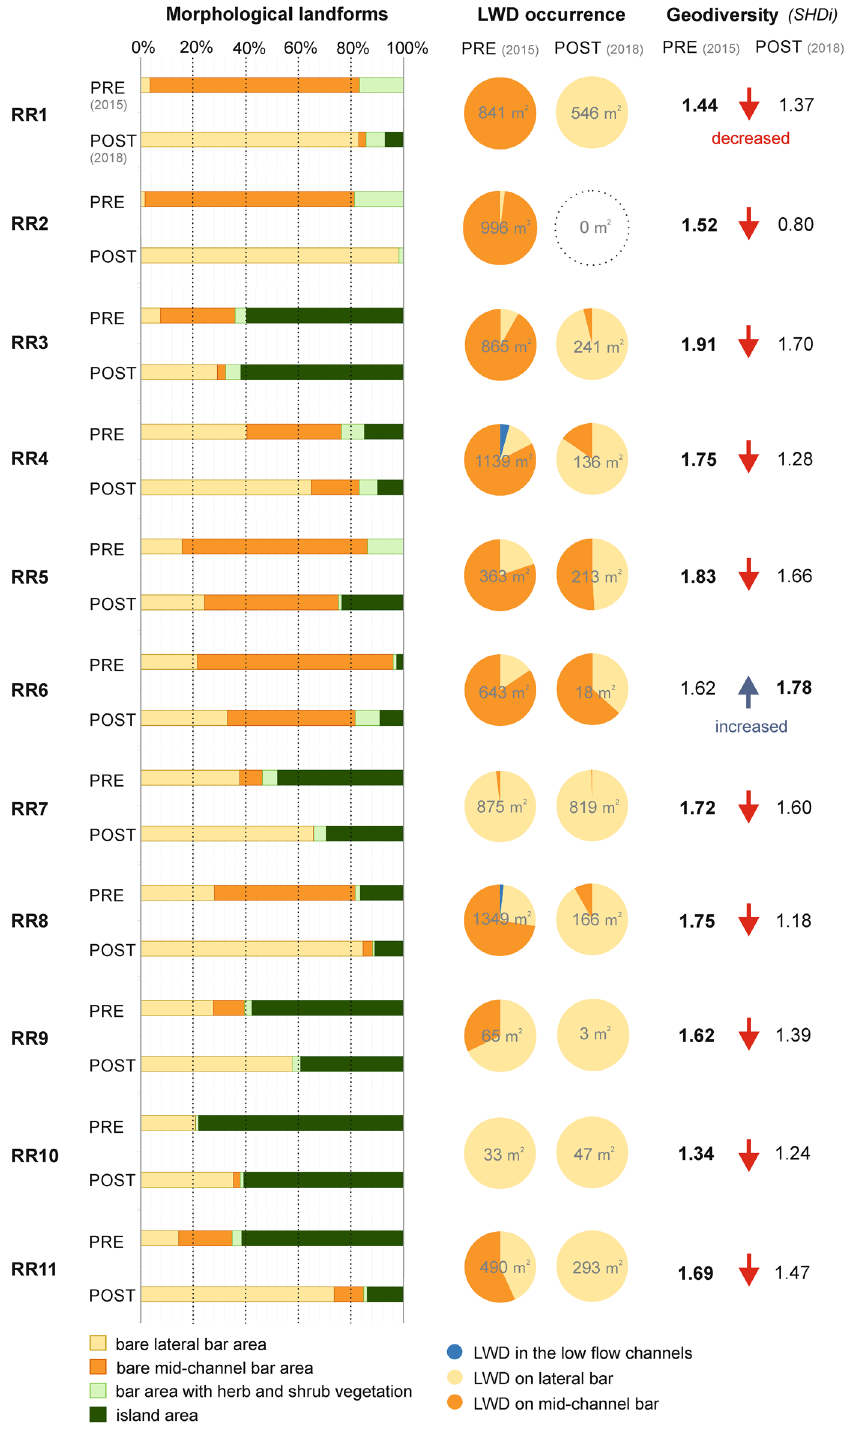
Figure 4. Differences in the morphological landform area of the braidplain, geodiversity status (increased/ decreased SHDI) and comparison of LWD accumulation area in PRE-flood (2015) and POST-flood management periods (2018) in all studied river reaches (RR1–11). Numbers inside a pie chart represent the total area of LWD accumulation identified in monitored river